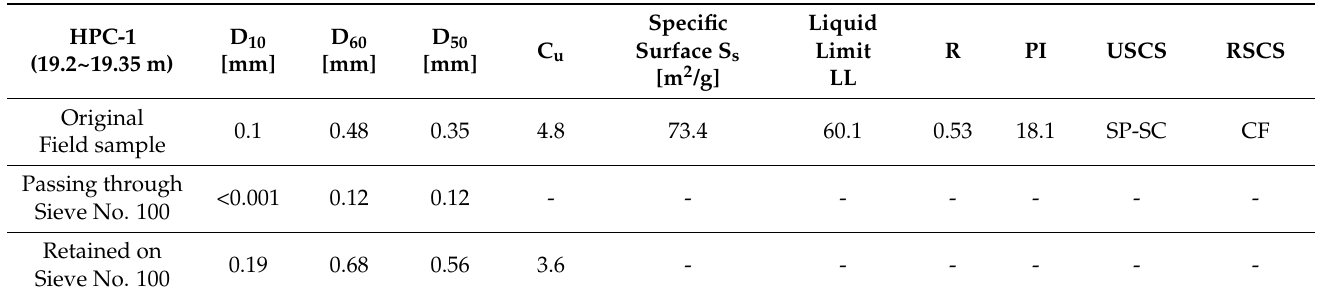
Table 1. Index properties of tested soil.